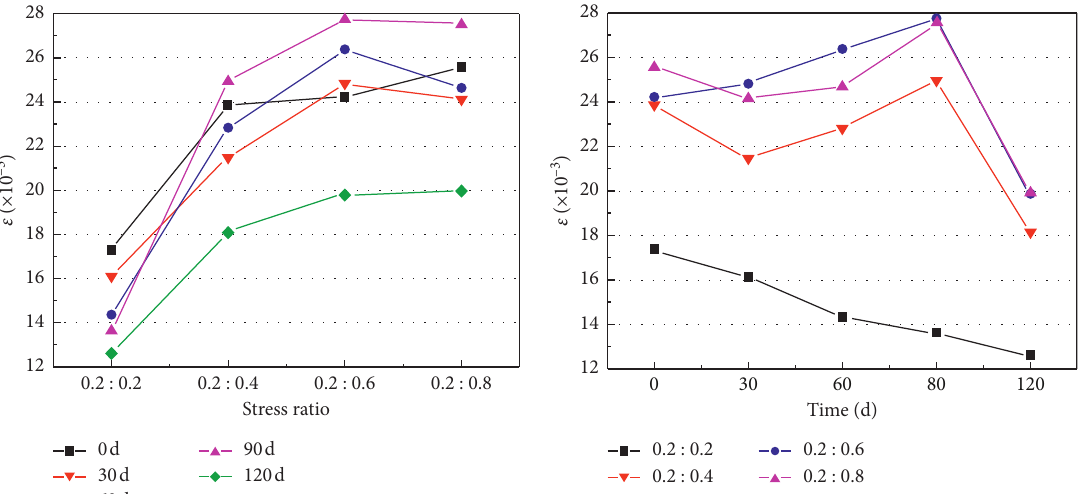
Figure 14: Variation of peak strain of concrete specimens.